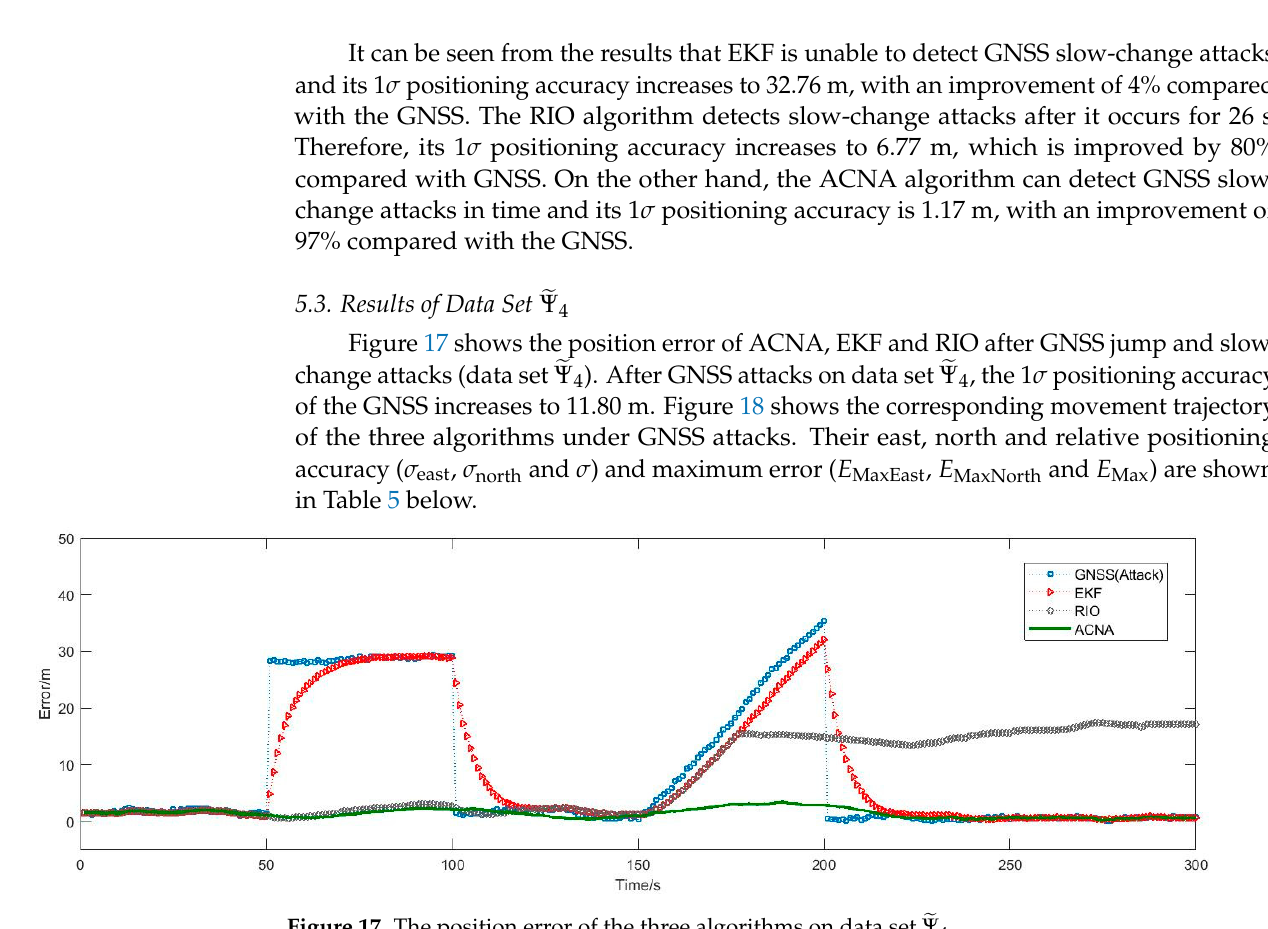
( c ) Figure 16. The trajectories of the three algorithms on data set 3 Ψ  : ( a ) EKF; ( b ) RIO; ( c ) ACNA. Table 4. The east, north and relative positioning accuracy and maximum error of the three algo- rithms in the data set